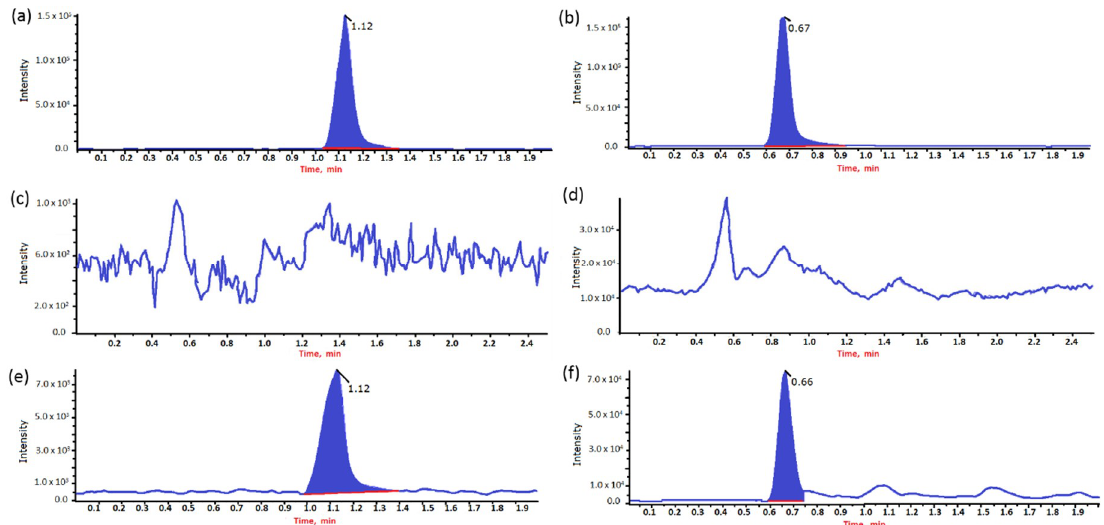
Figure 1 . Chromatograms of florfenicol (FF) in pure standard solutions, blank samples, and samples fortified with FF and florfenicol amine (FFA) at a concentration of 50 μg·kg −1 . ( a ) Pure standard of FF; ( b ) pure standard of FFA; ( c ) blank claw sample of FF; ( d ) blank claw sample of FFA; ( e ) chromatograms of sample fortified with FF; ( f ) chromatograms of sample fortified with FFA.